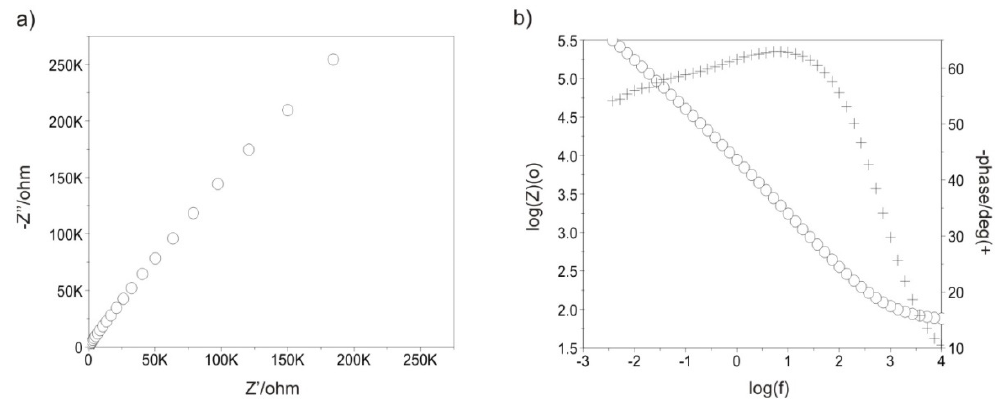
Figure 10. Impedance spectra determined for the initial state of the electropolished samples: ( a ) Nyquist diagram, ( b ) Bode diagram.